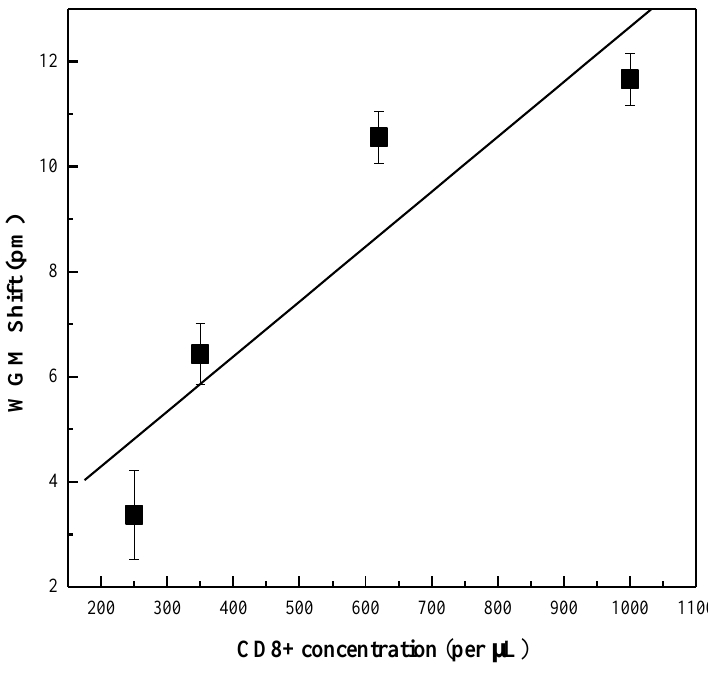
Figure 4. Spectral shift recorded for various concentrations of CD8+ T-Lymphocytes. Error bars are based on standard deviation obtained from 10